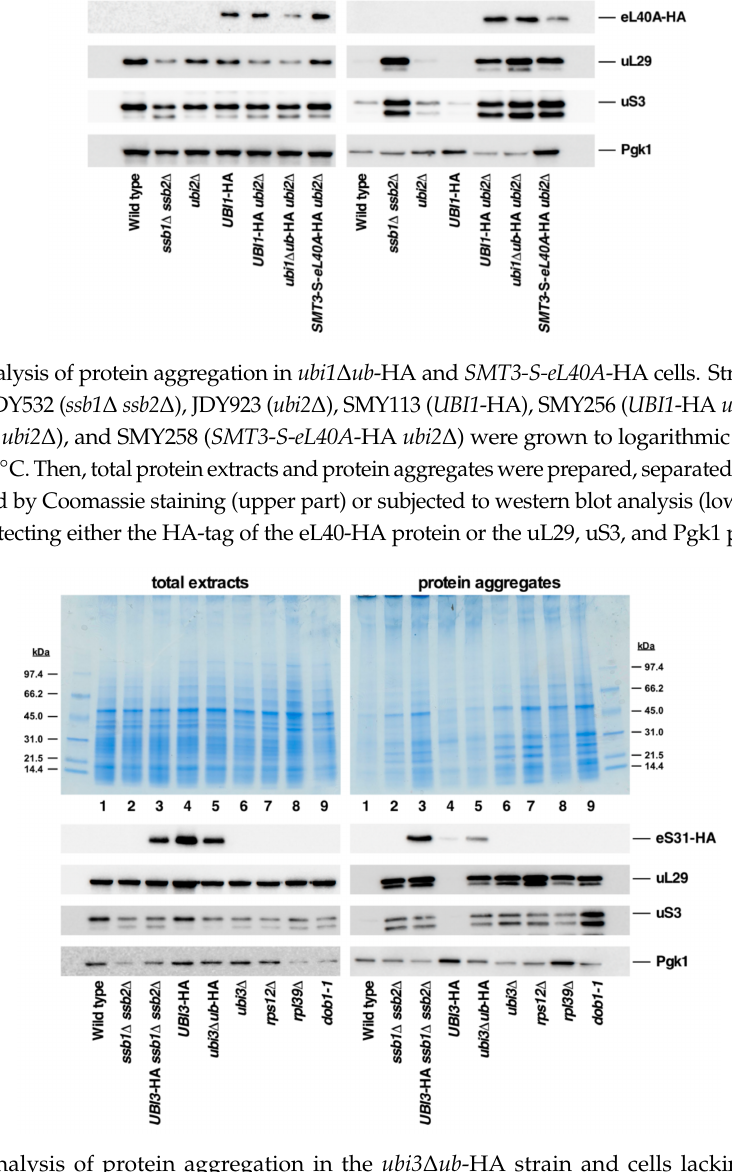
Figure 9. Analysis of protein aggregation in the ubi3 ∆ ub -HA strain and cells lacking individual r-proteins or being defective in ribosome biogenesis. Strains W303-1A (Wild type), JDY532 ( ssb1 ∆ ssb2 ∆ ), SMY324 ( UBI3 -HA ssb1 ∆ ssb2 ∆ ), TLY56.D3 ( UBI3 -HA), TLY61.A2 ( ubi3 ∆ ub -HA), TLY14.3C ( ubi3 ∆ ), SMY315 ( rps12 ∆ ), ORY211 ( rpl39 ∆ ), and MS157-1A ( dob1-1 ) were grown to logarithmic